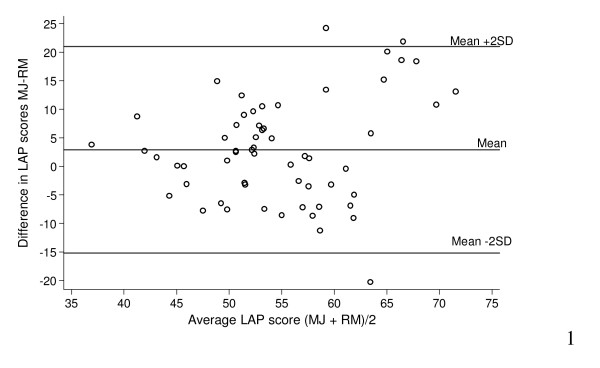
Bland-Altman plot.